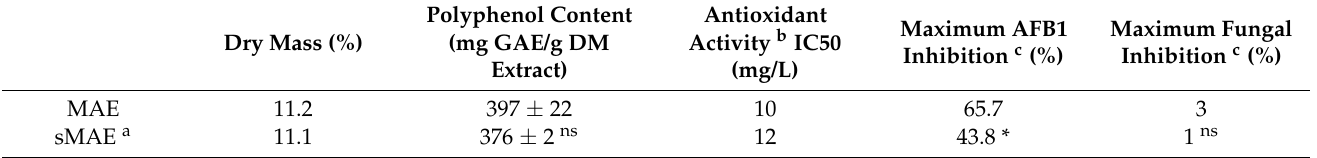
Table 1. Characterization of the aqueous extract at time 0 and after one year of storage at − 20 ◦ C. Polyphenol Dry Mass (%)